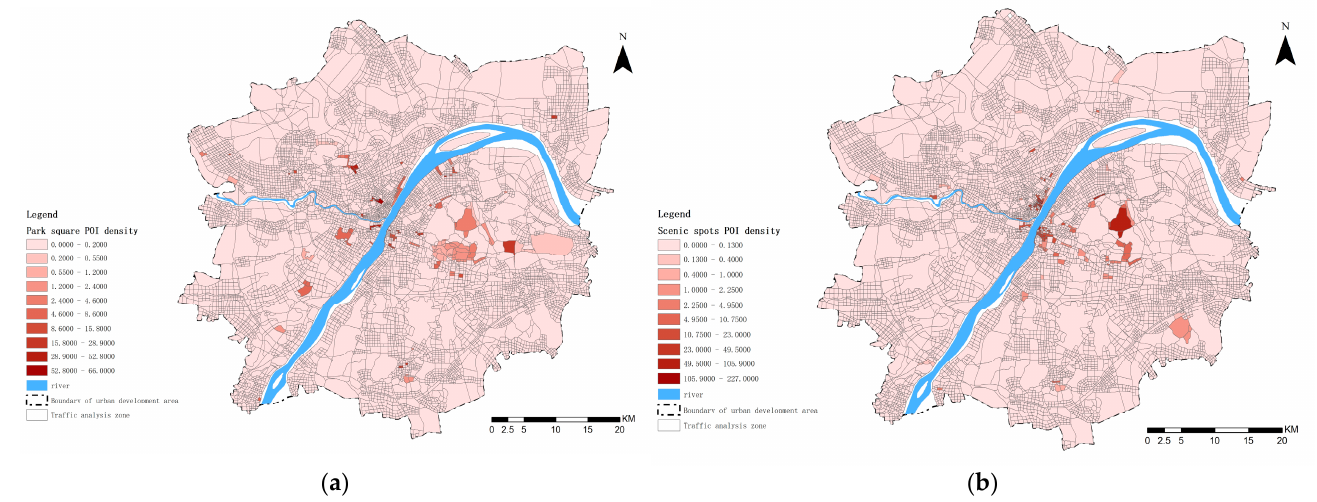
Figure 11. Green and open spaces: ( a ) Park square POI density; ( b ) Scenic spots POI density.